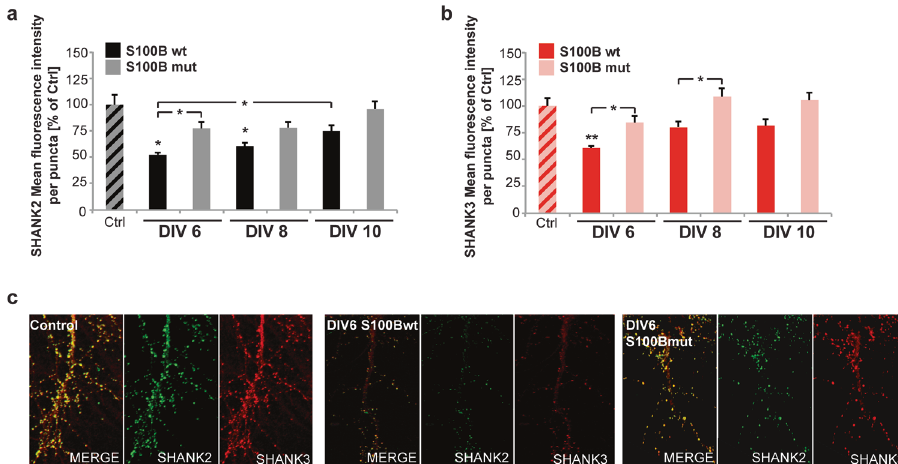
Fig. 2 Chronic exposure to S100B has pronounced effects on developing synapses. a, b Primary hippocampal neurons were treated with either 30 μ M S100Bwt or S100Bmut from DIV6, DIV8 or DIV10 until DIV11. a Treatment at early developmental stages (DIV6, DIV8) in combination with a prolonged exposure to S100Bwt but not S100Bmut led to a signi fi cant reduction in immuno fl uorescence intensities of SHANK2 immunoreactive puncta ( n = 8 – 10 cells, Welch ’ s ANOVA, F = 12.518, p < 0.001; post-hoc analyses: control vs. wt DIV6 , p < 0.05; control vs. wt DIV8 , p < 0.05; control vs. mut DIV6 , p > 0.05; wt DIV6 vs. mut DIV6 , p < 0.05; wt DIV6 vs. wt DIV10 , p < 0.05). b Decreased fl uorescence intensity of SHANK3 immunoreactive puncta was seen in hippocampal neurons treated with S100Bwt protein from DIV6 or DIV8 on compared to untreated control (DIV6) or S100Bmut treated cells (DIV8) respectively. Non-zinc-binding S100Bmut protein did not affect SHANK3 = 7.7018, p < 0.001; fl uorescence intensity independent of time-point of administration ( n = 8 – 10 cells, one way ANOVA, F (6,61)